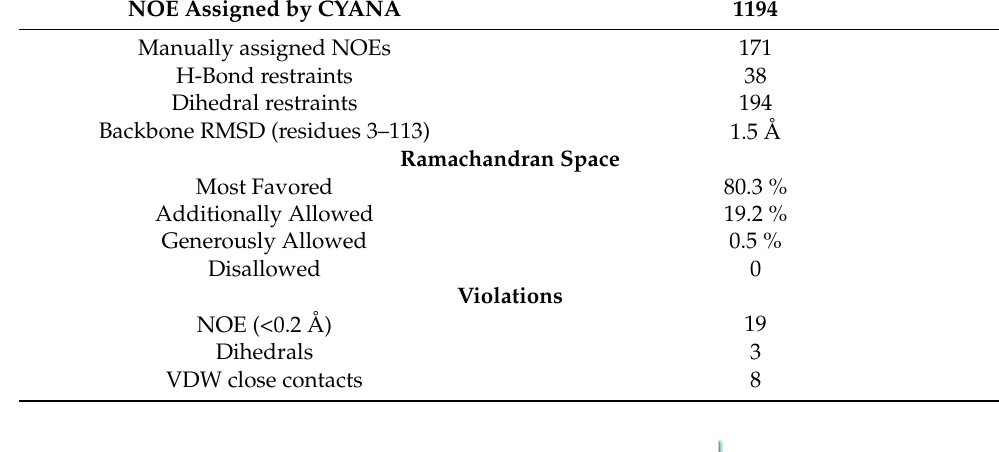
Table 1. Summary of restraints used for NMR structure determination and structure refinement statistics (20 structures) of experimental restraints.